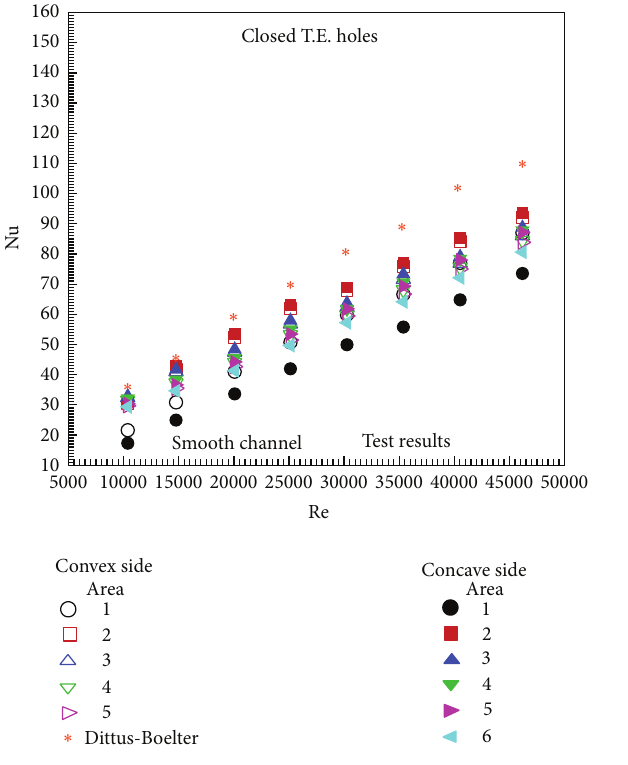
Figure 8: Measured heat transfer results in the smooth channel on the convex and concave walls for the case of closed trailing-edge holes and open channel